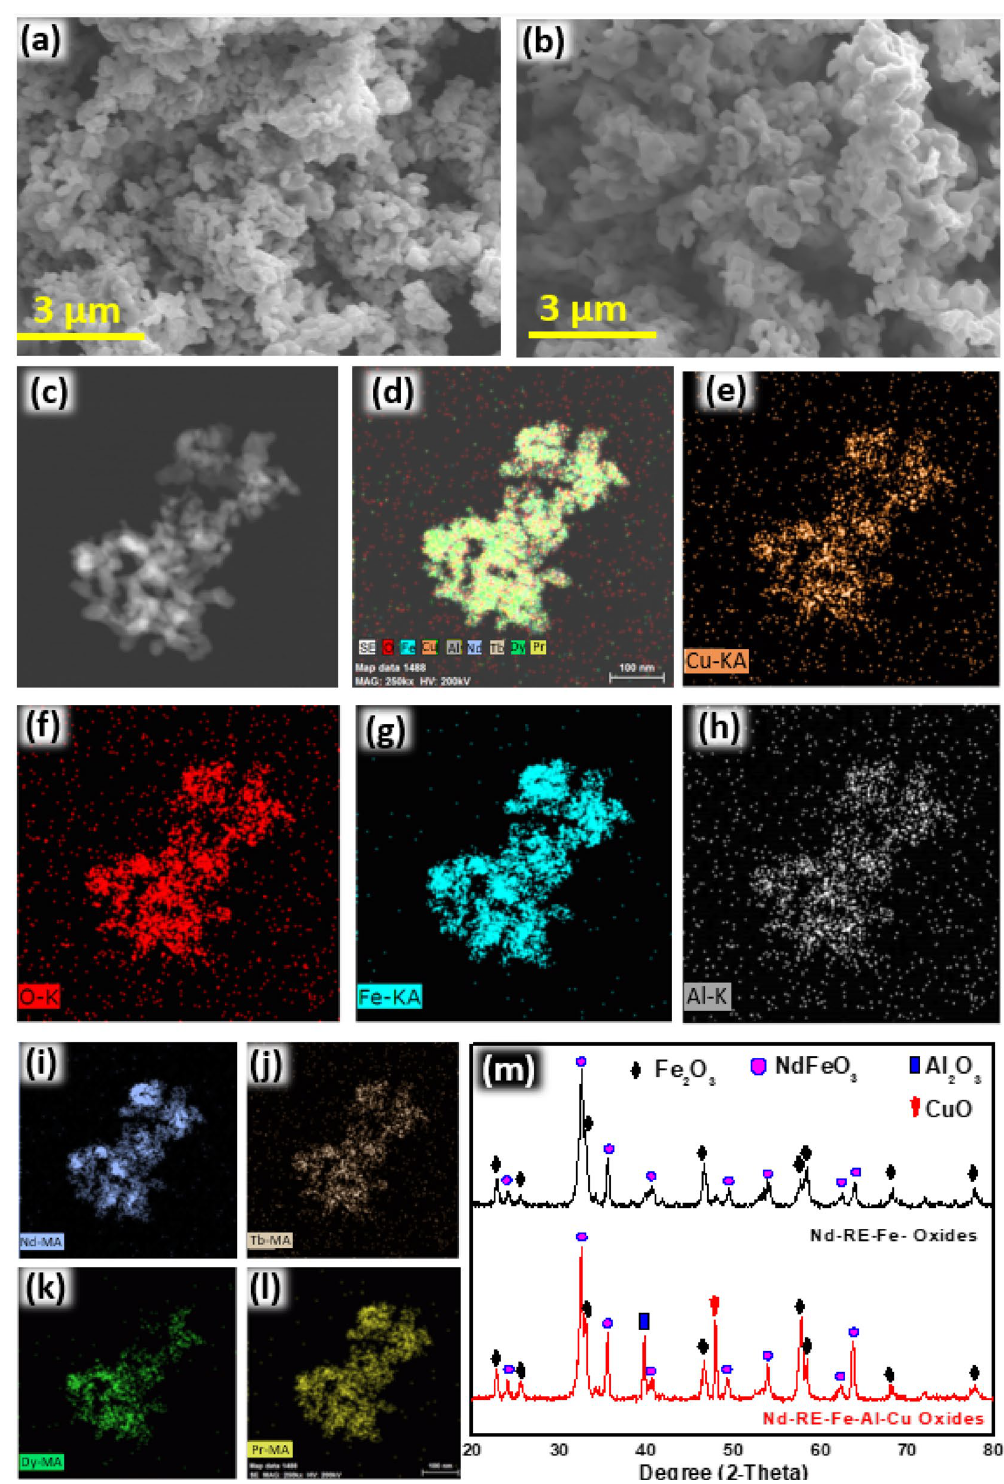
Figure 3. SEM images of ( a ) Nd-RE-Fe-oxide ( b ) Nd-RE-Fe-Al-Cu-oxide ( c – l ) TEM and TEM-EDS images of Nd-RE-Fe-Al-Cu-oxide ( m ) XRD patterns of Nd-RE-Fe-oxide and